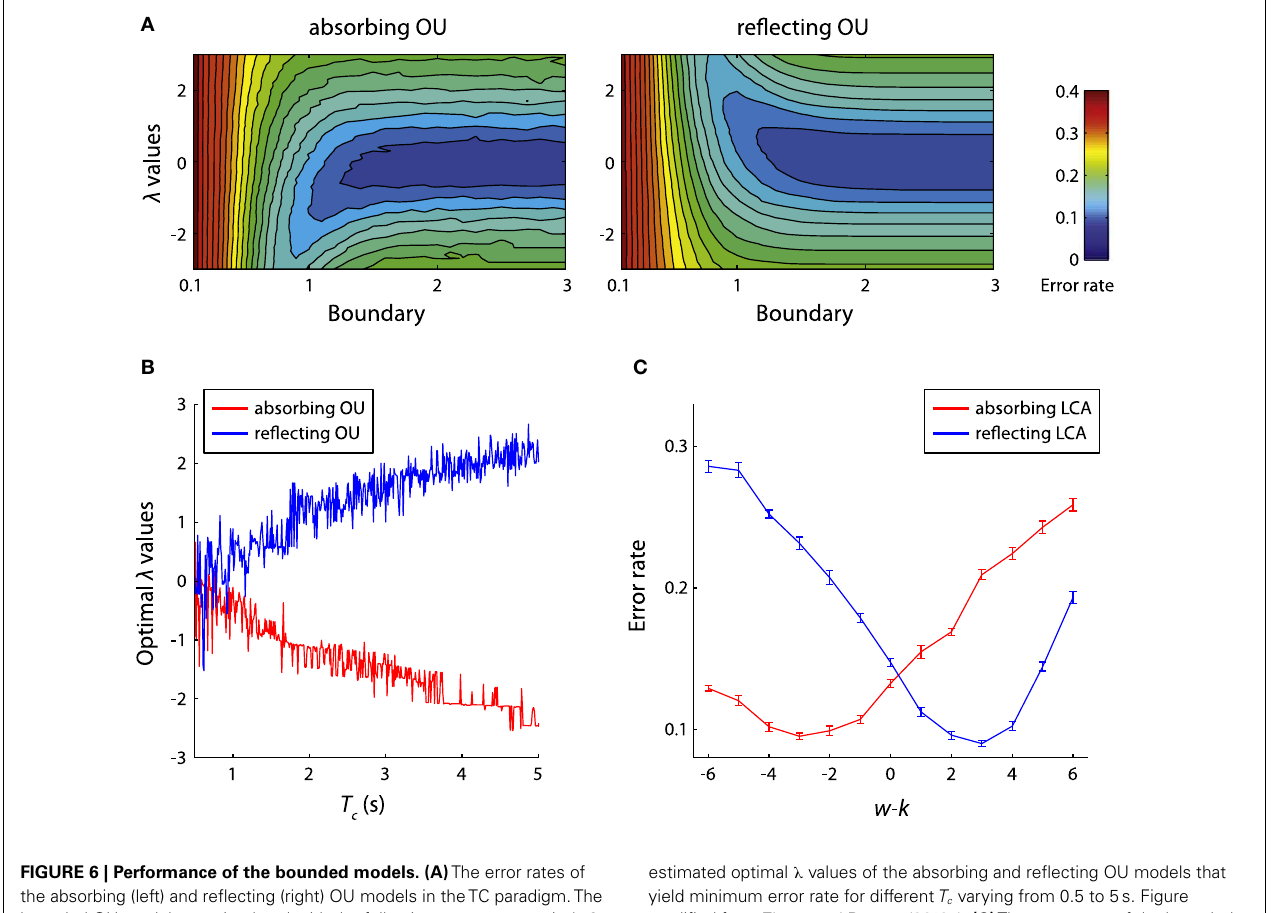
FIGURE 6 | Performance of the bounded models. (A) The error rates of the absorbing (left) and reflecting (right) OU models in theTC paradigm.The bounded OU models are simulated with the following parameters: λ in ( − 3, 3) with step 0.1, b in (0.1, 3) with step 0.1, µ = σ = 1s − 1 , and T c = 1s.The contour plots illustrate the mean error rates of the bounded OU models estimated from 10,000 simulations for each possible parameter combinations. Figure modified from Zhang and Bogacz (2010a). (B) The